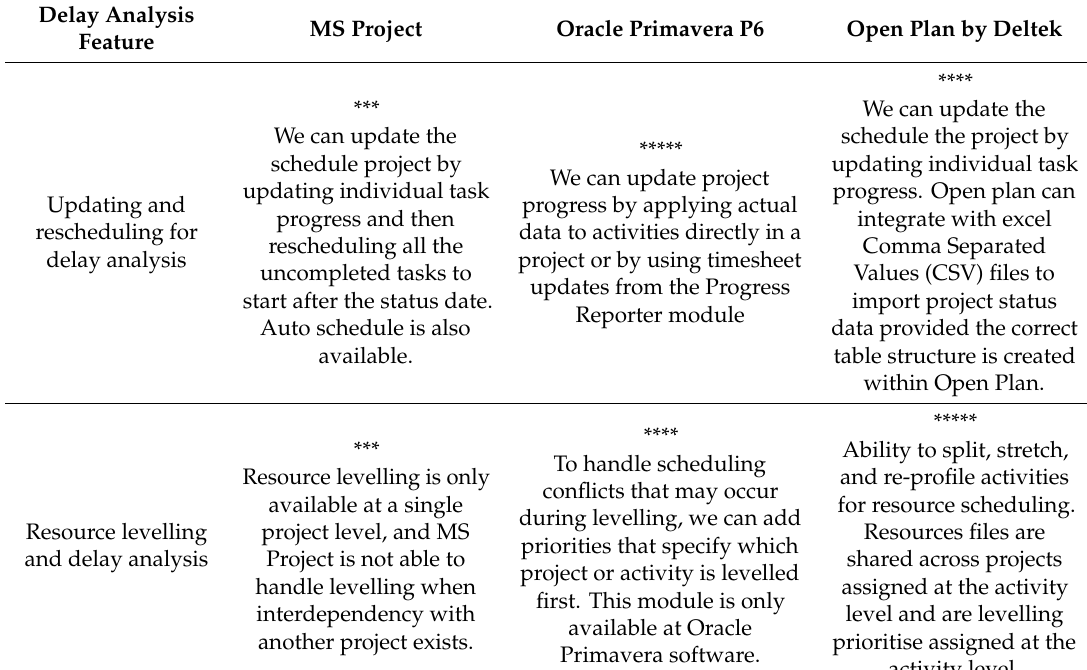
Table 10. Project delay analysis feature comparison between Microsoft (MS) Project, Primavera P6, and Open Plan by Deltek.